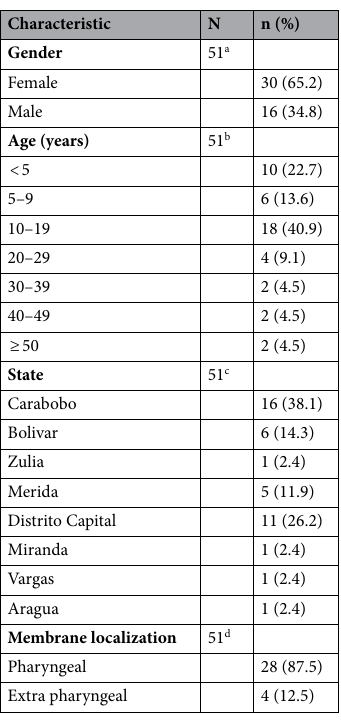
Table 1. Descriptive characteristics of the study participants (N = 51) recruited between December 2017 and December 2018 in Venezuela. N, n sample size. a Missing gender information in 5 patients. b Missing age information in 7 patients. c Missing state information in 9 patients. d Missing membrane localization information in 19